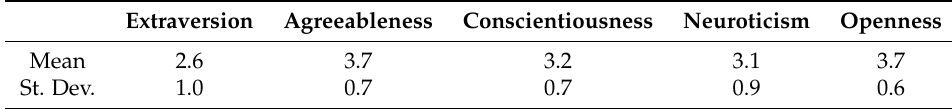
Table 5. Pre-study Big-Five personality scores (1 (low) to 5 (high)).